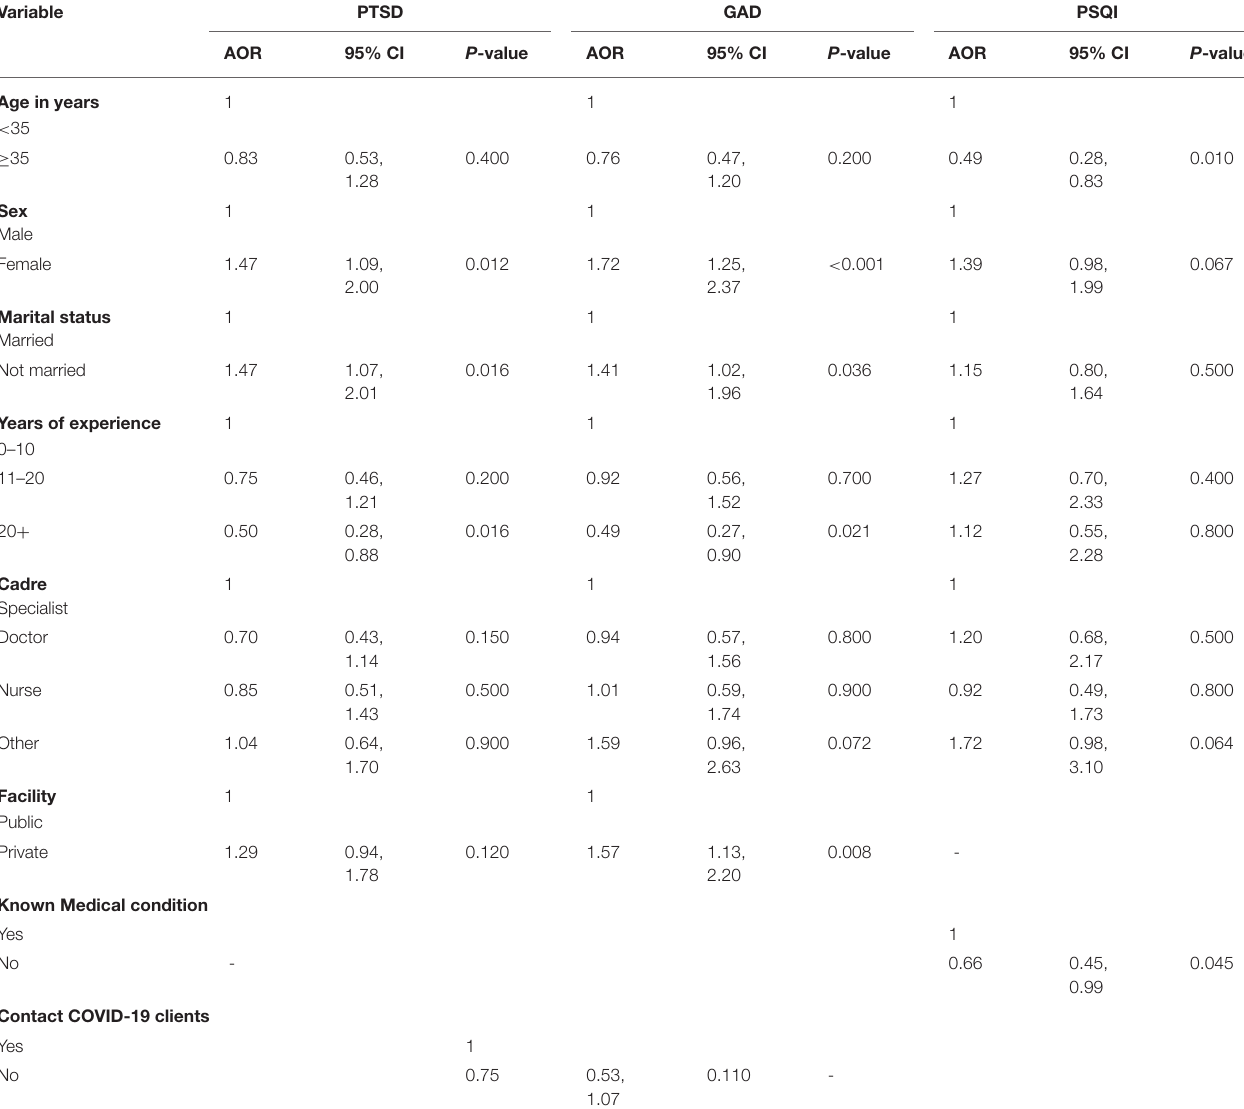
TABLE 4 | Multivariate logistic